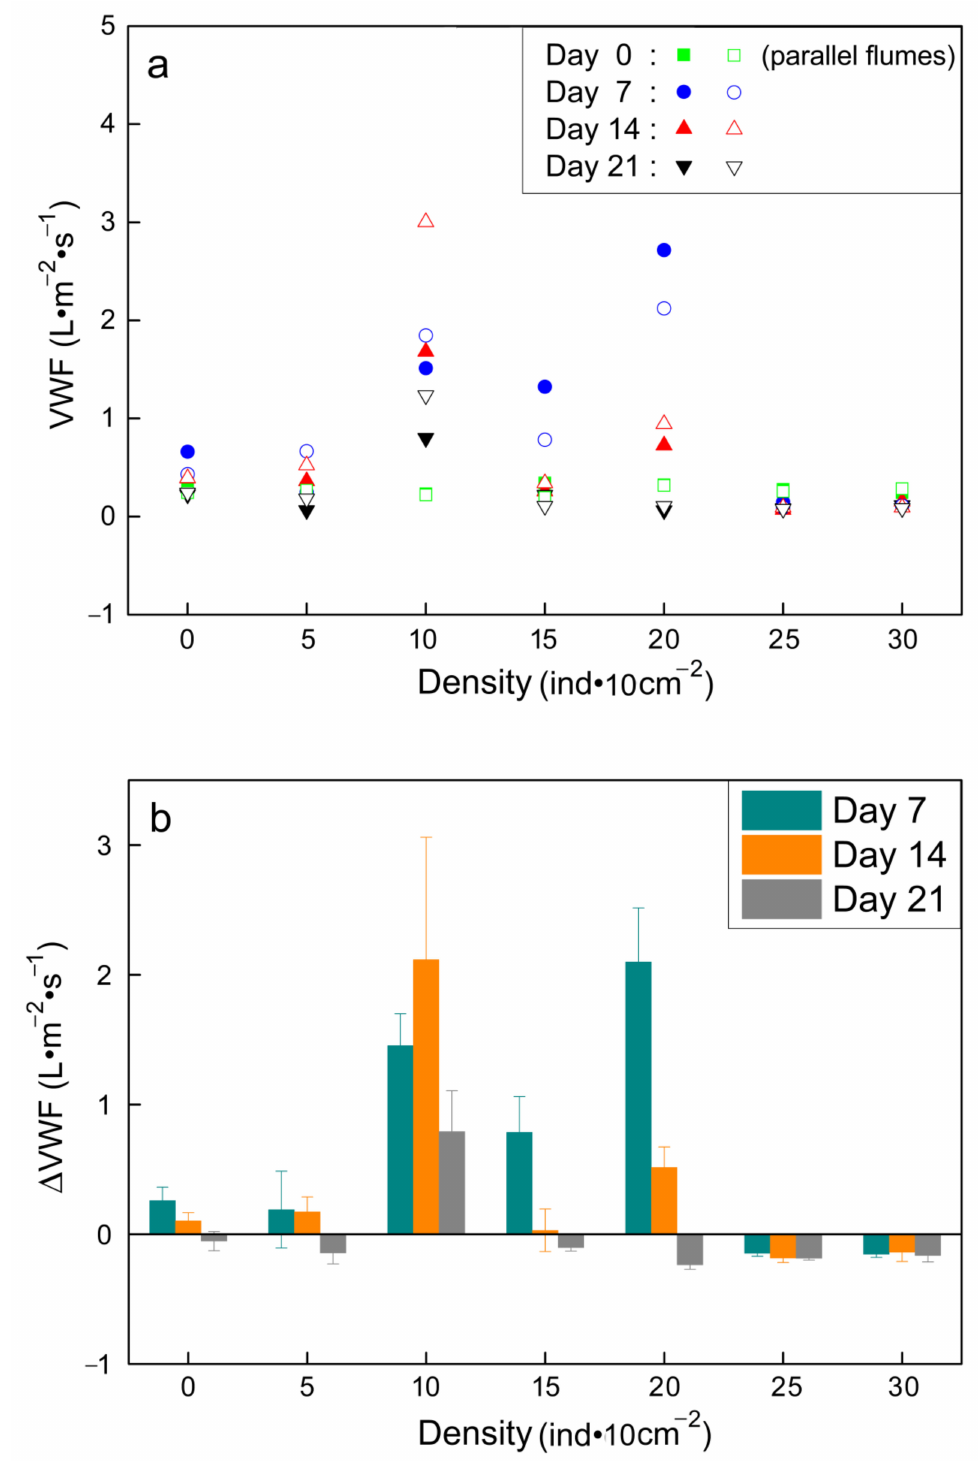
Figure 7. Changes of vertical water flux (VWF) and ∆ VWF with 7-day intervals under seven biological densities (( a ) VWF and ( b ) ∆ VWF). Each density treatment has two parallel flumes. The presented vertical water fluxes in ( b ) are the mean ± standard deviation (SD) of the two parallel groups in each density treatment at each measurement